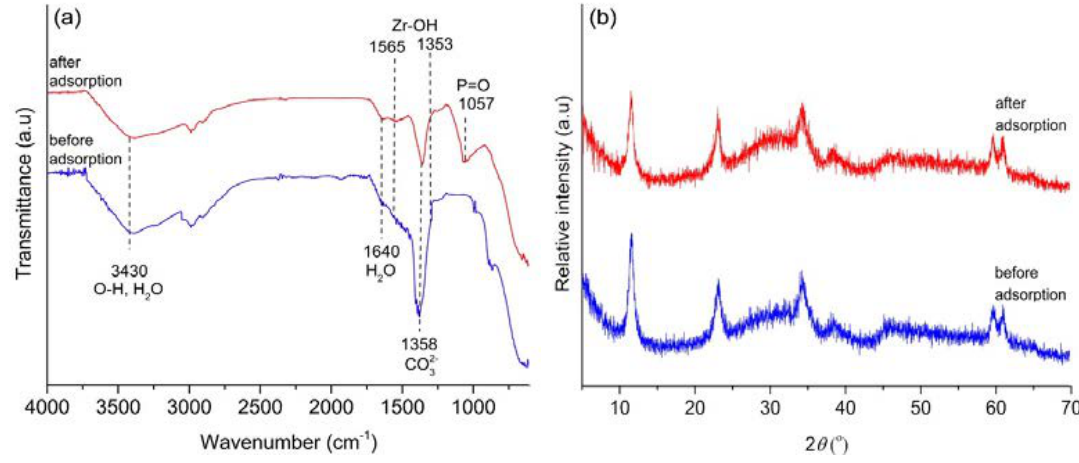
Fig. 6: (a) FTIR spectra and (b) XRD patterns of am-Zr/MgFe-LDH composite before and after adsorption